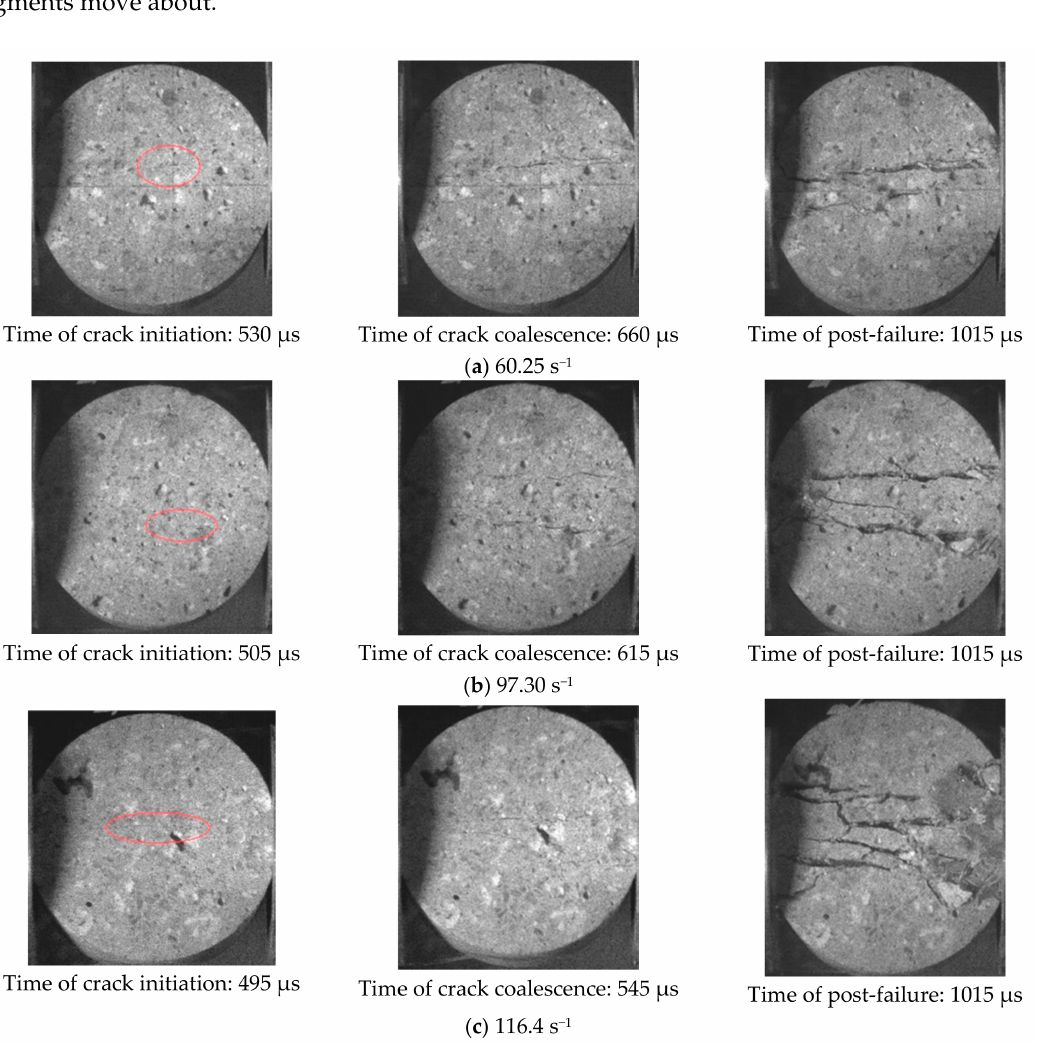
Figure 7. Failure modes of the concrete at different strain rates. ( a ) Strain rate is 60.25 s − 1 ; ( b ) strain rate is 97.30 s − 1 ; ( c ) strain rate is 116.4 s − 1